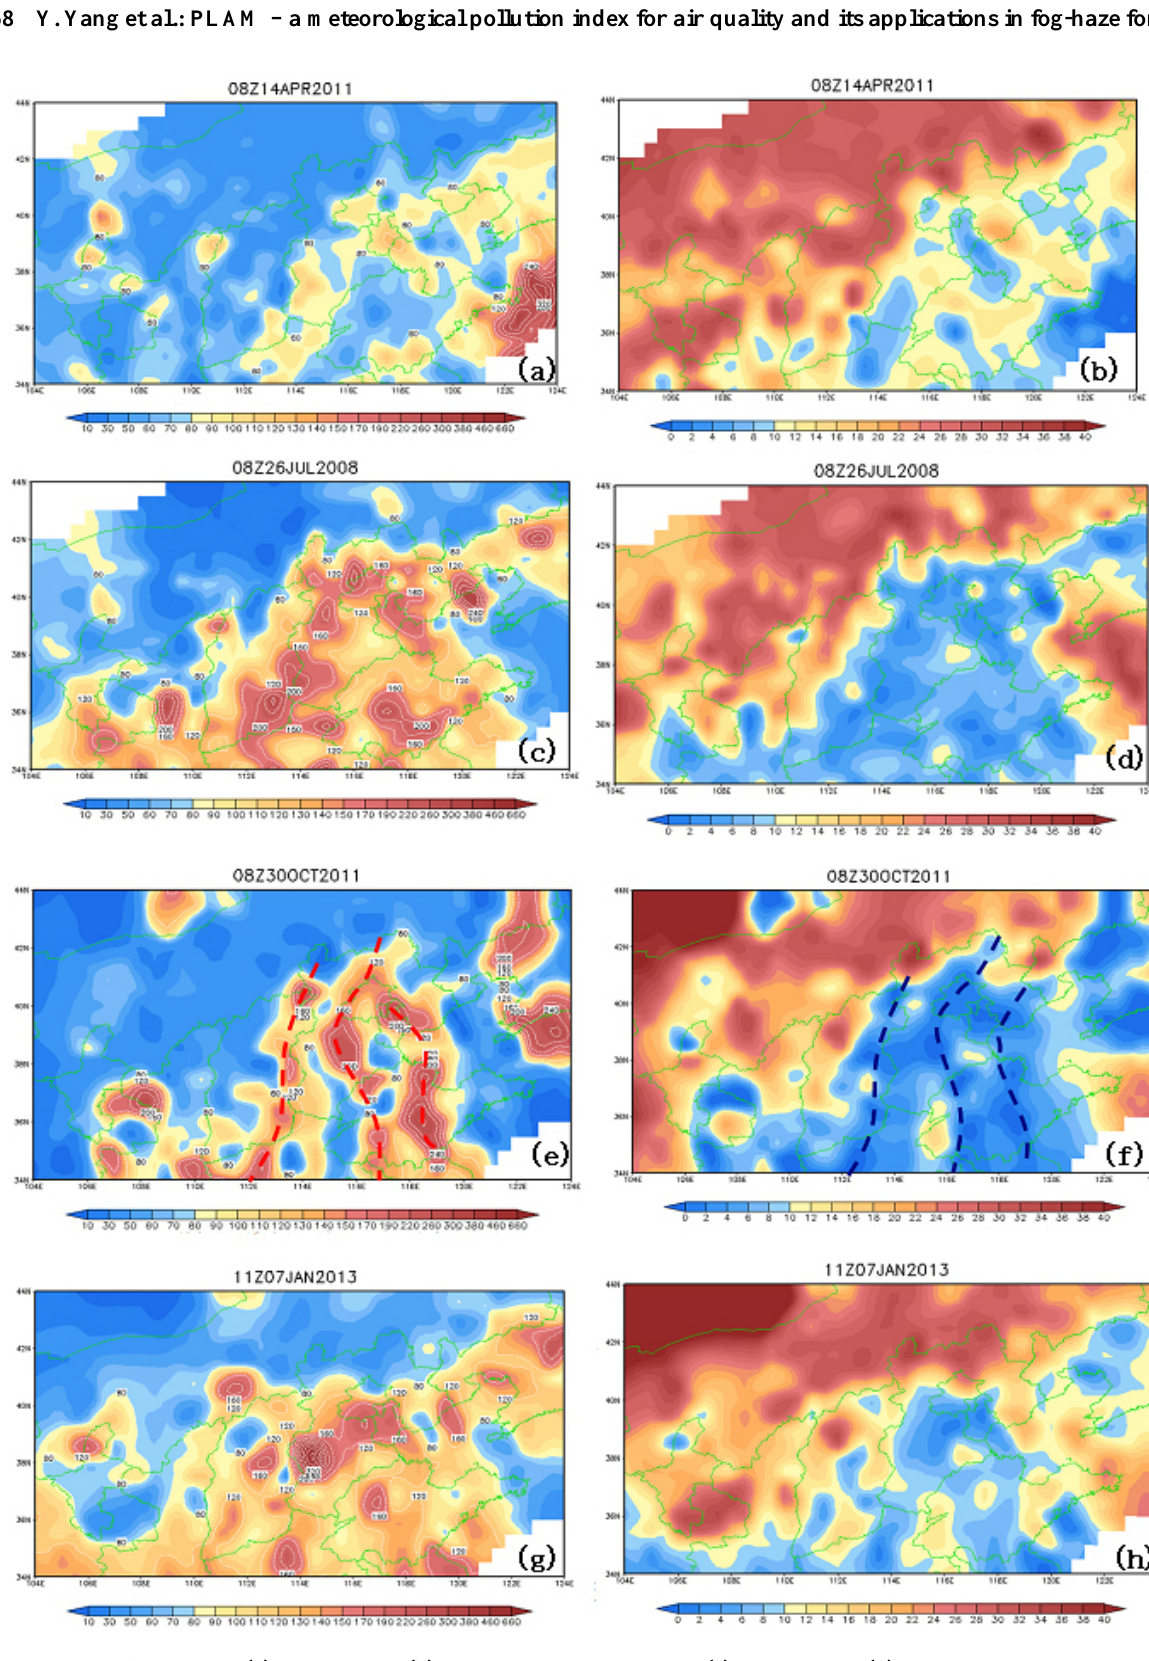
Figure 3. Cases for PLAM/h (a) and visibility (b) on 14 April 2011, PLAM/h (c) and visibility (d) on 26 July 2008, PLAM/h (e) and visibility (f) on 30 October 2011, and PLAM/h (g) and visibility (h) on 7 January